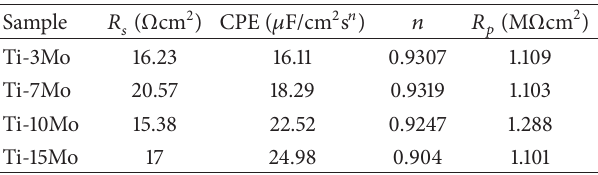
Table 3: Electrical parameters obtained from the EIS